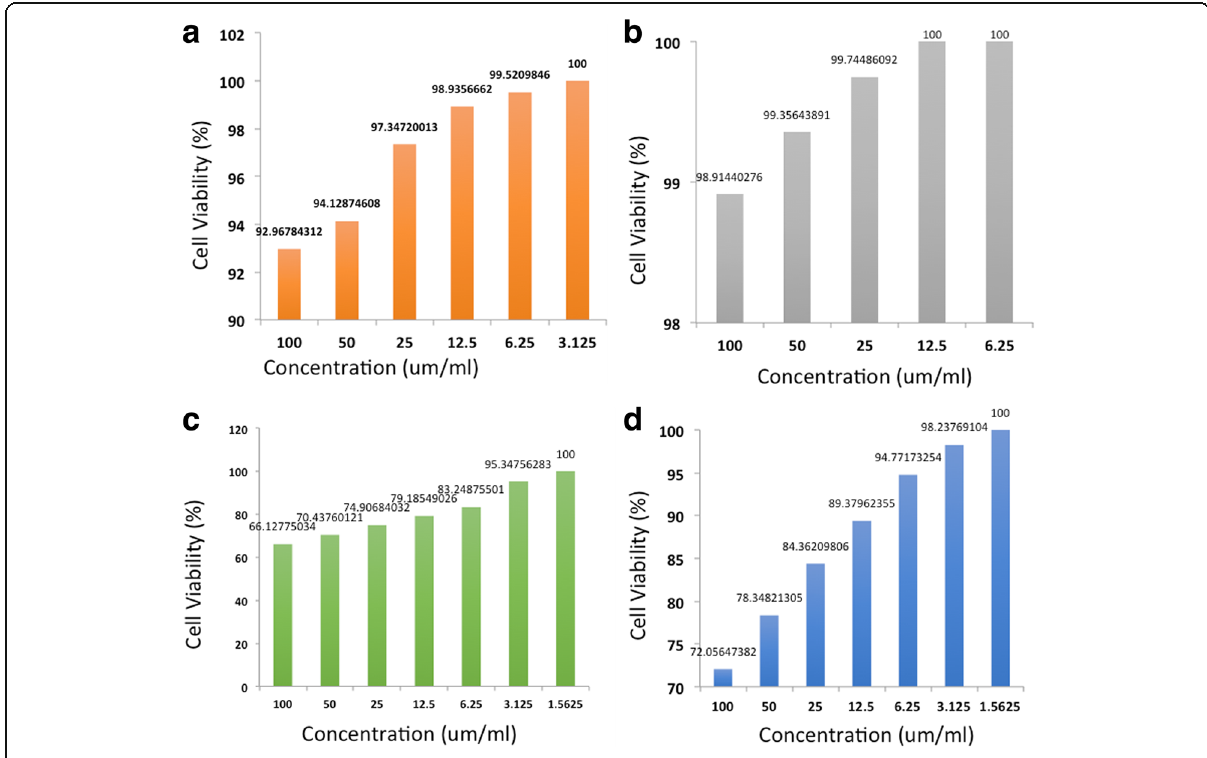
Fig. 5 The cytotoxicity analysis of a CNC, b NFC, c CNF, and d